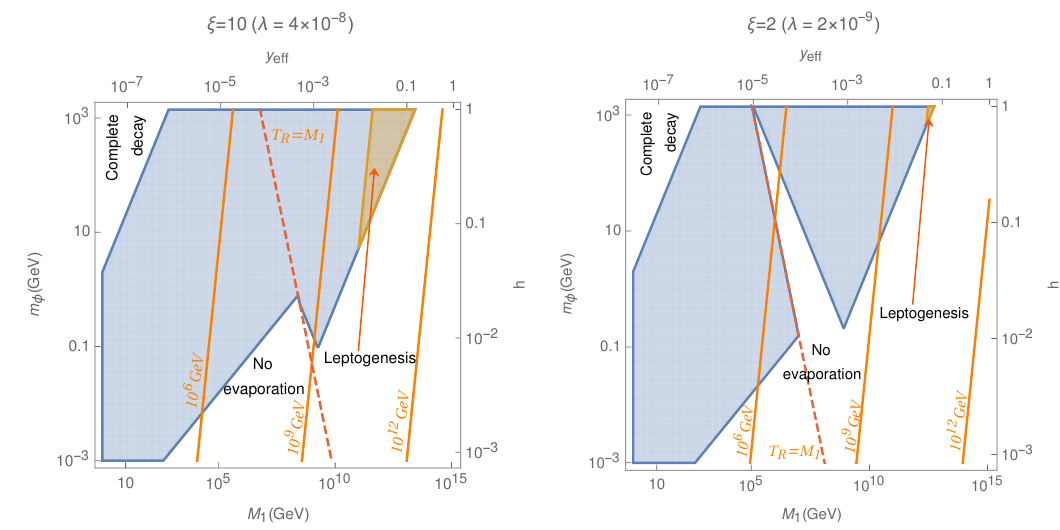
Figure 8 . Constraints on model parameters for (cid:24) = 2 ; 10, taking g ? = 100. The shaded blue regions correspond to parameter values satisfying all constraints in the WIMPlaton scenario and the shaded orange regions correspond to consistent scenarios for thermal leptogenesis with T R > 10 10 GeV. Orange lines represent di(cid:11)erent values for the reheating temperatures and the dashed line, M 1 = T R , limits the evaporation conditions. Condition (4.43) de(cid:12)nes the no decay and no reheating regions and conditions (4.44), (4.45) limit the no-evaporation